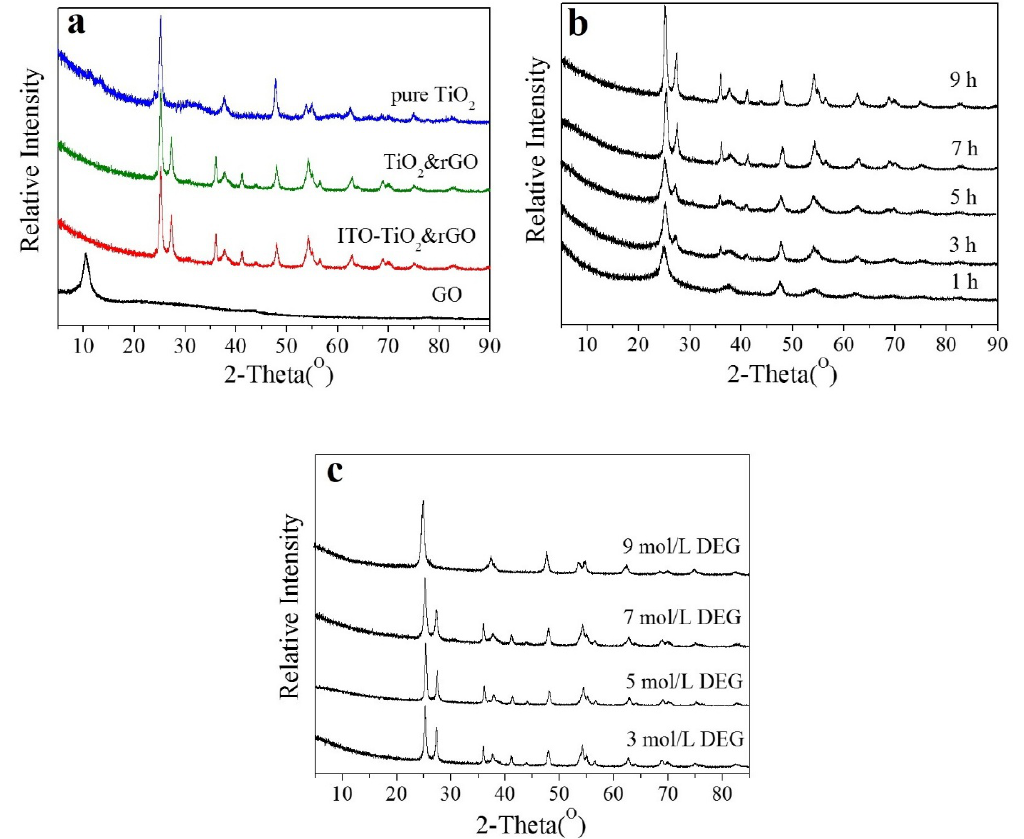
Figure 2. X-ray diffractometry (XRD) patterns of ( a ) TiO 2 , rGO and TiO 2 , and ITO-rGO and TiO 2 , ( b ) ITO-rGO and TiO 2 prepared at different times, and ( c ) ITO-rGO and TiO 2 prepared in different diethylene glycol (DEG) concentrations.